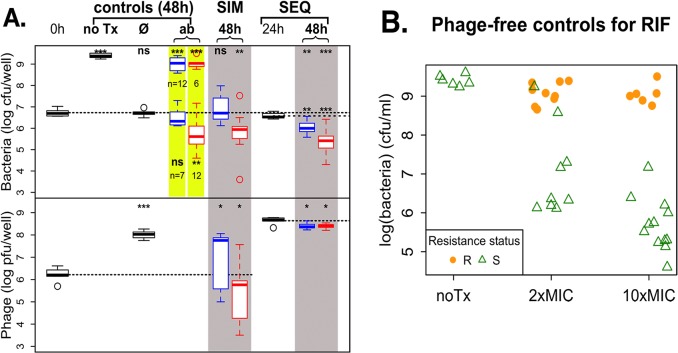
Treatment of S. aureus biofilm with RIF and phage.A. Combined action of phage and RIF on S. aureus biofilms. The legend is the same as for Fig 2. 20 wells were used for antibiotic-only controls, and simultaneous and sequential treatments, at each antibiotic concentration. The 2× and 10×MIC RIF-only control data are highlighted in yellow: some wells became turbid over the 48h of incubation (bacterial density ~ 1e9; data is the same as the points at the top of Fig 4B), and some wells remained clear (bacterial density ~ 1e5–1e7; data is the same as the points at the bottom of Fig 4B). The number of wells in each category is indicated below the corresponding box. B. Resistance status of phage-free controls. Bacterial densities are shown for each well, in solid orange dots for resistant wells and open green triangles for sensitive wells. Note that some of the cultures dosed with 2×MIC of RIF reached high densities (>1e8 cfu/mL) even though they appear to be sensitive to RIF when tested on plates containing 10×MIC RIF.